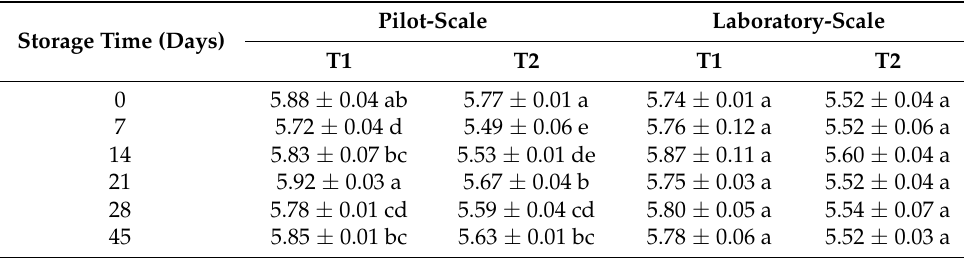
Table 1. The pH results were obtained according to the methods, treatments and storage time applied to blank processed cheese